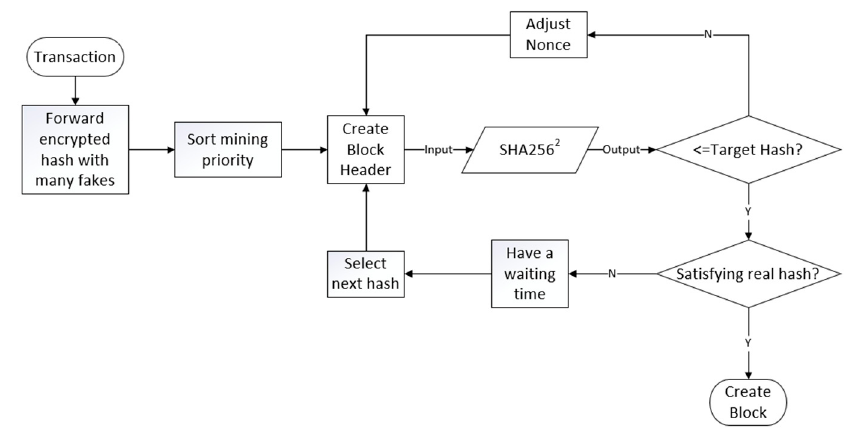
Figure 5. PoP (Proof-of-Probability) algorithm flow.